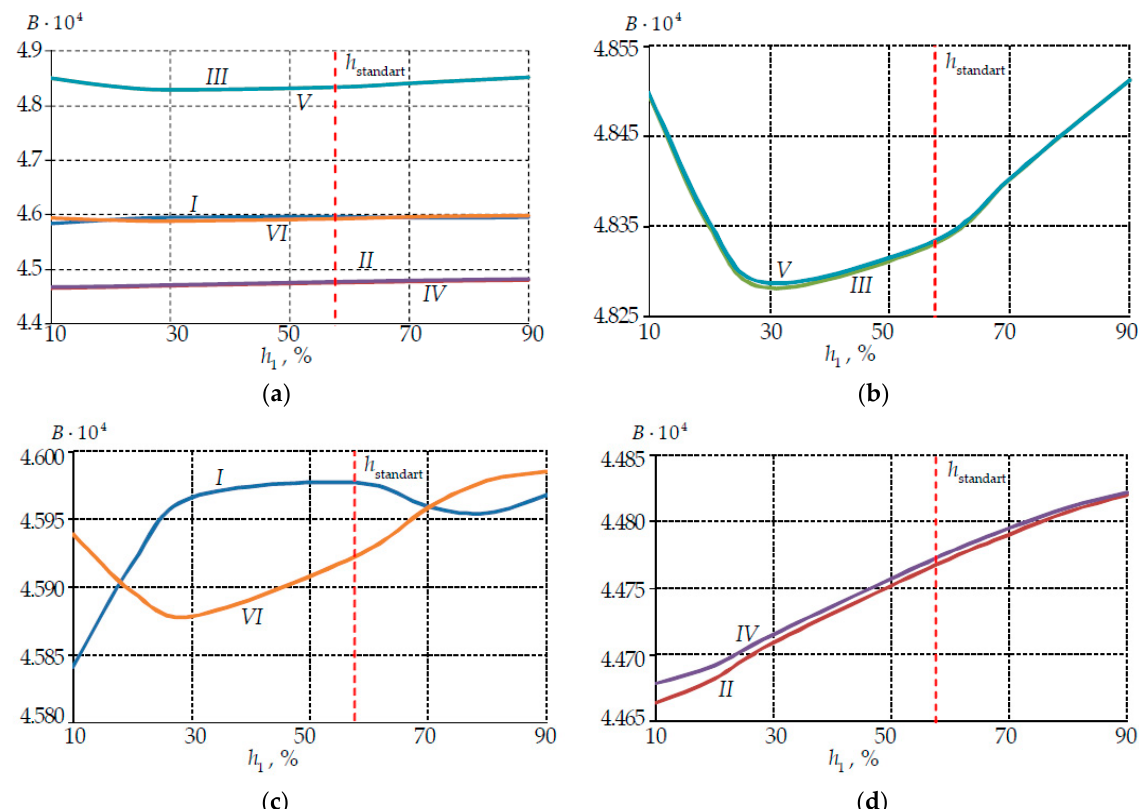
Figure 11. Dependence of modal birefringence on the PC thickness: ( a ) all thermal cycle holding zones; ( b ) the holding zones at − 60 °C; ( c ) the holding zones at 23 °C; ( d ) the holding zones at 60°C; I–VI are numbers of the holding zone at constant temperature; I is 23 °C; II is 60 °C; III is − 60 °C; IV is 60 °C; V is − 60 °C; VI is 23 °C.